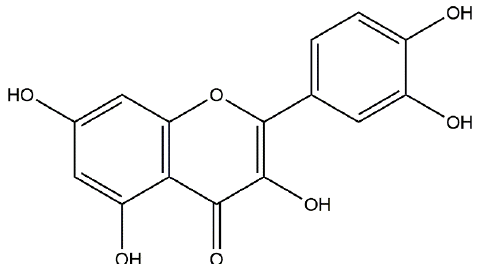
Figure 1. Chemical structure of quercetin.